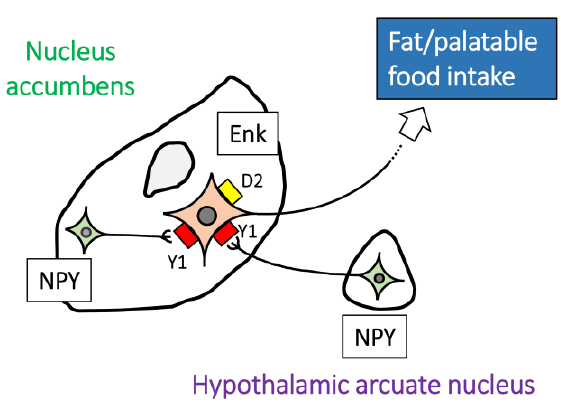
Figure 2. Schematic of NPY-mediated food intake in the NAc. NPY neurons in the NAc or NPY afferents from hypothalamic arcuate nucleus regulate fat/palatable food intake via accumbal enkephalin neurons expressing Y1 and dopamine D2 receptors. Enk, enkephalin neurons; NPY, neuropeptide Y neurons.